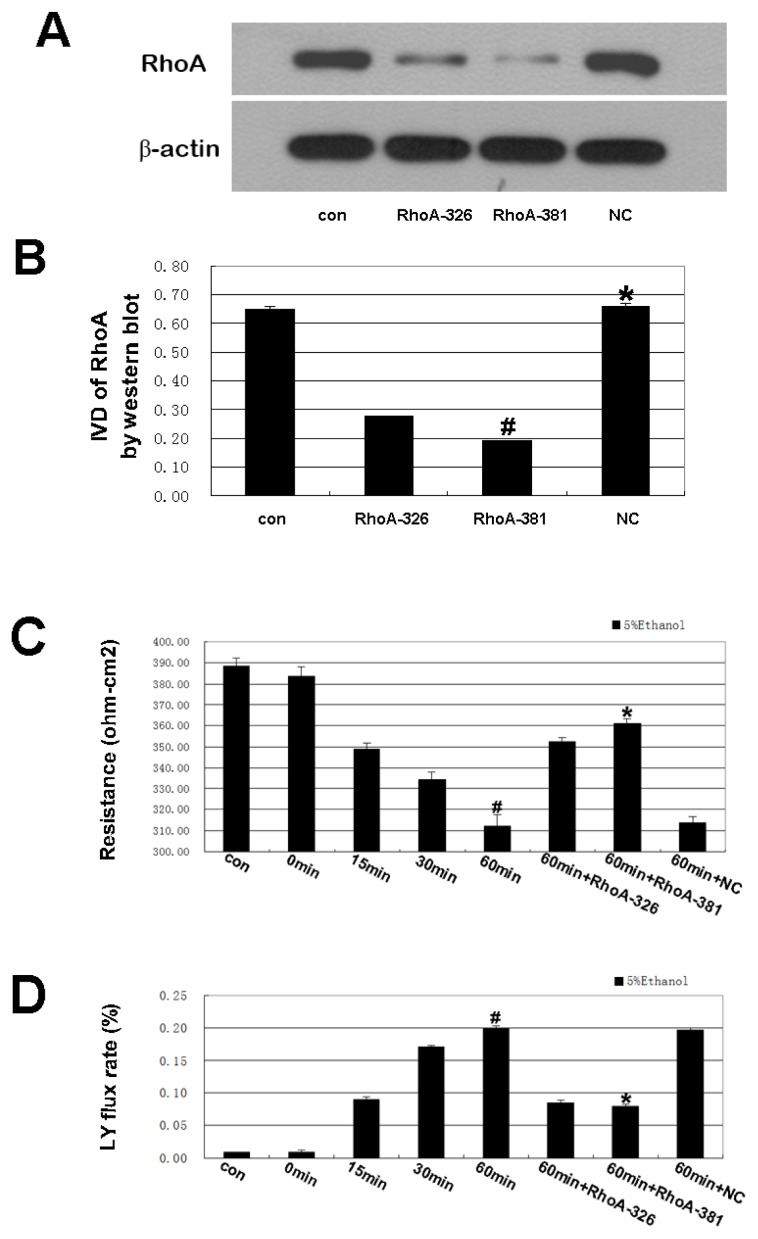
(A,B) RhoA protein levels measured by Western blot analysis after shRNAs transfection. The blots shown are representative of three independent experiments. The results showed a significantly downregulated protein level of RhoA by two shRNA compared to the control group. Negative control (NC) shRNA group showed no statistically significant decrease expression of RhoA compared to the control group. Values are means ± SD (n = 4 each). #p < 0.01 vs. control group; *p > 0.05 vs. control group. (C) Effect of RhoA shRNA interference on changes in the TEER of IEB. Caco-2 cells were pretreated with RhoA shRNA interference and then treated with 5% ethanol for 60 min. Values are the mean ± SD (n = 4 each). #p < 0.01 vs. 0 min group. *p < 0.01 vs. 60 min group. (D) Effect of RhoA shRNA interference on changes in luminal yellow (LY) flux of the IEB. Caco-2 cells were pretreated with RhoA shRNA interference and then treated with 5% ethanol for 60 min. Values are the mean ± SD (n = 4 each). #p < 0.01 vs. 0 min group. *p < 0.01 vs. 60 min group.